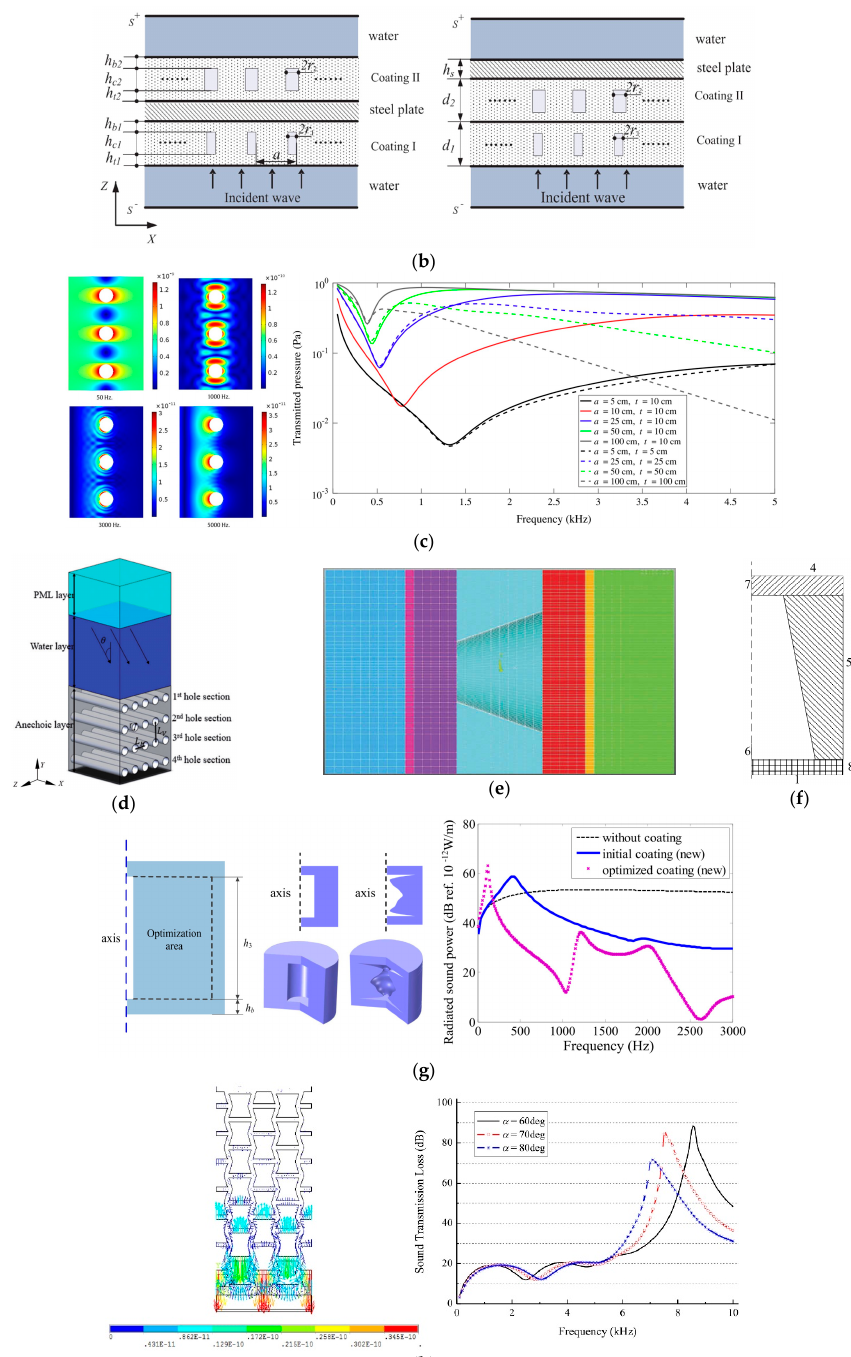
Figure 4. Design and optimization of the acoustic cavity. ( a ) Two-dimensional analytical model, periodic numerical model, and sound absorption coefficients of the Alberich anechoic coating [15]. ( b ) Coatings on both surfaces and the outer surface of a steel plate and their absorption coefficients [16]. ( c ) Deformation of the polydimethylsiloxane (PDMS) medium and transmitted pressure obtained analytically [18]. ( d ) Schematic of the finite element method (FEM) model [19]. ( e ) Cross-section of the absorbent coating, including a cone frustum hole [20]. ( f ) Two-dimensional axisymmetric model [21]. ( g ) Sketch of the optimization area for the cavity, initial cavity, optimized cavity, and radiated sound power associated with di ff erent coatings attached to an infinite plate [22]. ( h ) Sound transmission loss and displacement contour of the negative Poisson’s ratio honeycomb-hole coatings